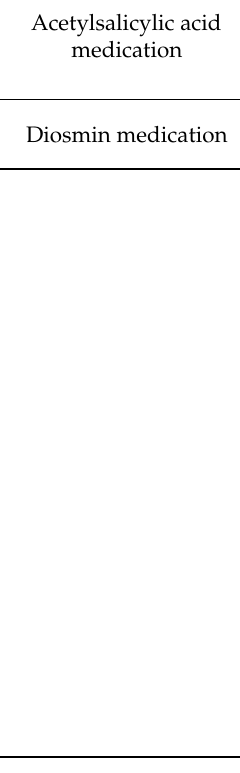
Table 4. Results of the multivariate linear regression performed using the expression of particular miRNA transcripts as a dependent variable and the characteristics of the studied subjects as indepen- dent variables. The table presents regression coefficients and associated p -values of characteristics resulting in p < 0.01. The entire results of the multivariate regression analysis are provided in Table S9.